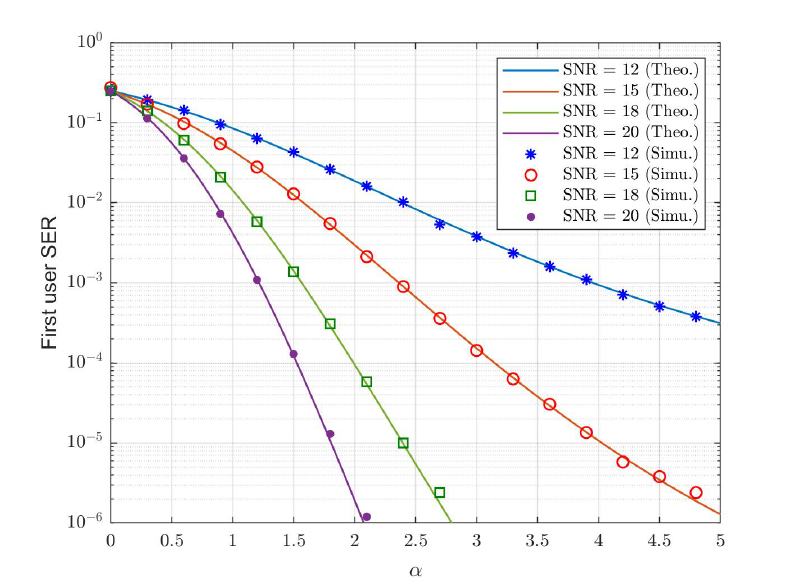
Figure 12. SER 1 with α at different SNR